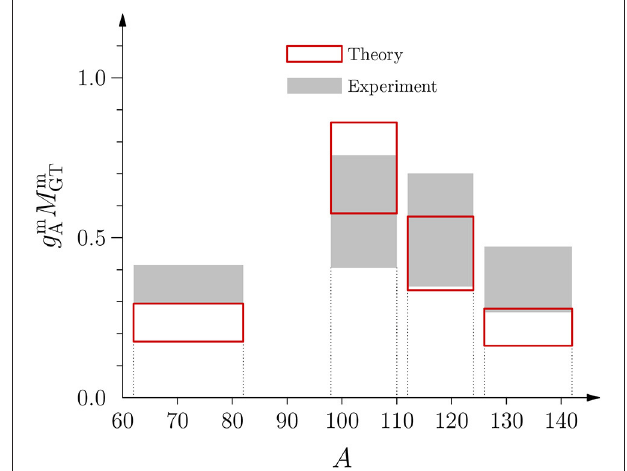
FIGURE 7 | Ranges of the experimental and theoretical mean NMEs for different mass ranges as deduced from